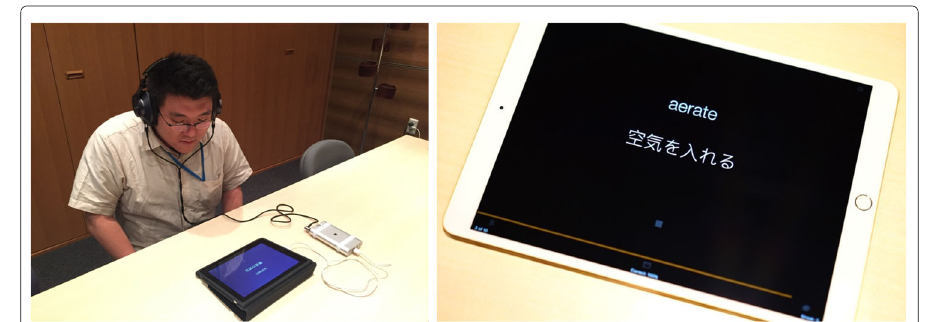
Fig. 3 Appearance of the